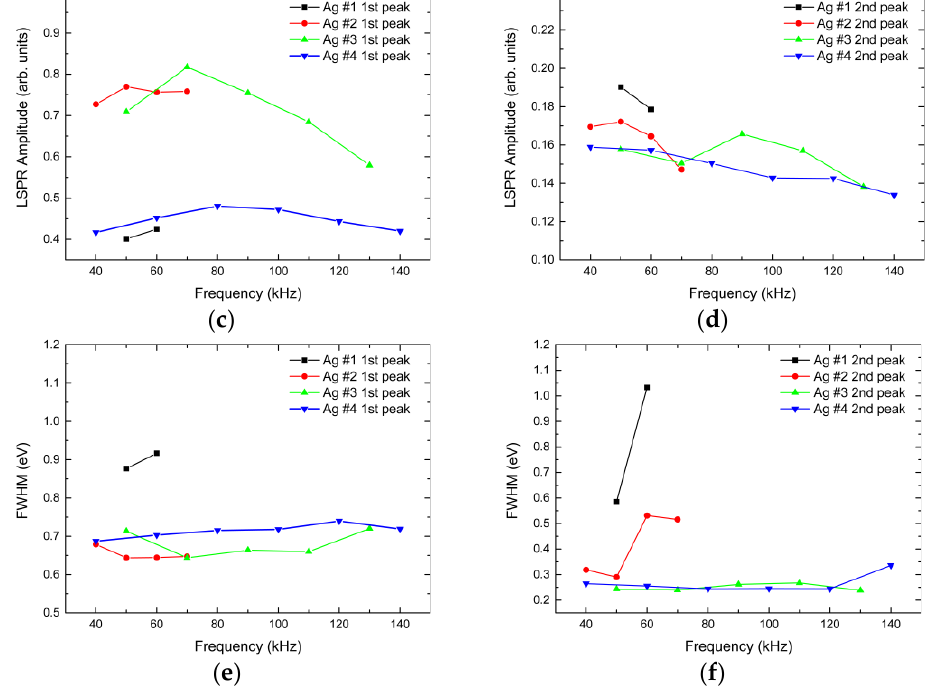
Figure 7. Graphic illustrations of the LSPR characteristics for all Ag films treated with various laser frequency settings: Ag #1 (13.5 nm), Ag #2 and Ag #3 (12.5 nm), and Ag #4 (6 nm). ( a , c , e ) Data for the main (first) peaks; ( b , d , f ) data for the secondary peaks. The LSPR position is shown in ( a , b ), while the LSPR amplitude and FWHM are depicted in ( c , d ) and ( e , f ), respectively. Table 3. LSPR characteristics as a function of the frequency. The fill spacing for Ag#1 was 0.05 mm, while for the rest of the films, it was 0.0125 mm. Specimen